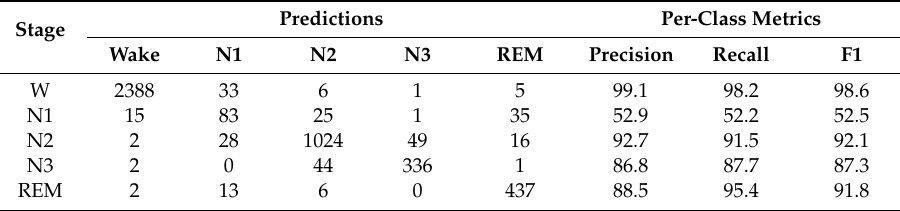
Table 3. Confusion matrix and overall performance on the sleep-edf dataset.